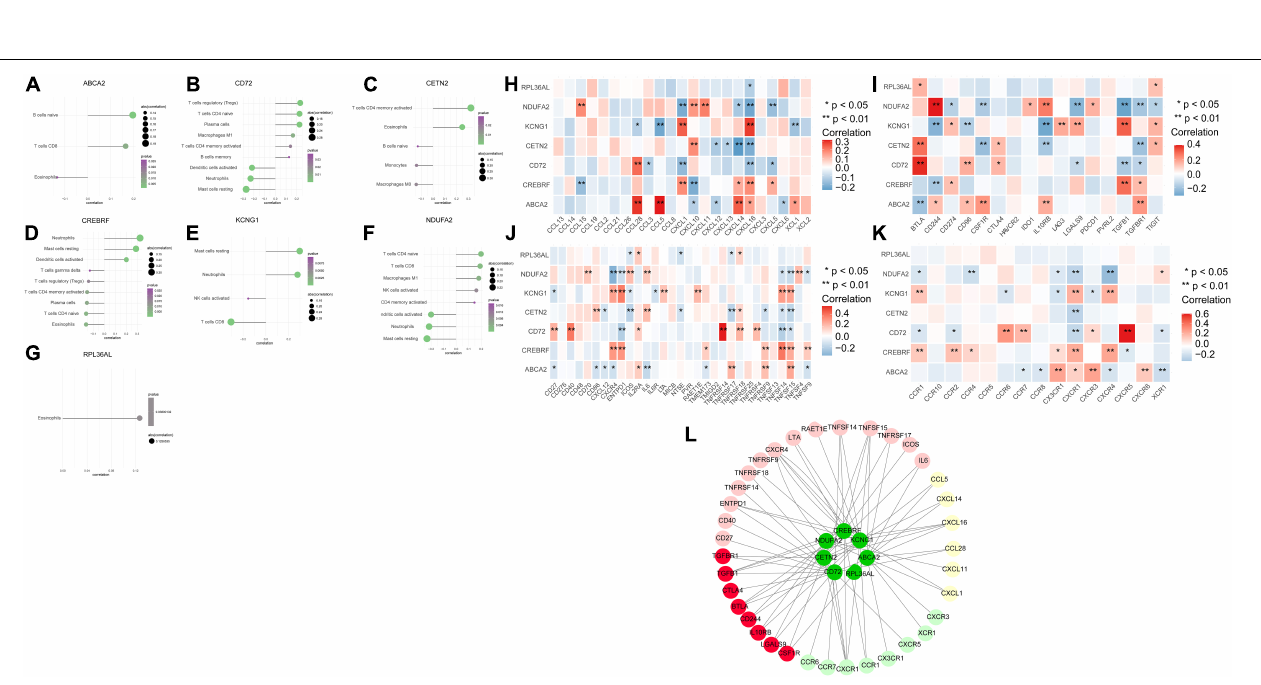
FIGURE 2 | The landscape of immune infiltration between AD and normal controls. (A,B) The box-plot diagram indicating the relative percentage of different types of immune cells and the heat map summarizing the score of immune infiltration between AD patients and non-AD patients. (C) The heat map shows the correlation in infiltration of innate immune cells by CIBERSORT. (D) The difference of immune infiltration between AD (red) and normal (blue) controls. ( P -values < 0.05 indicated statistical significance).